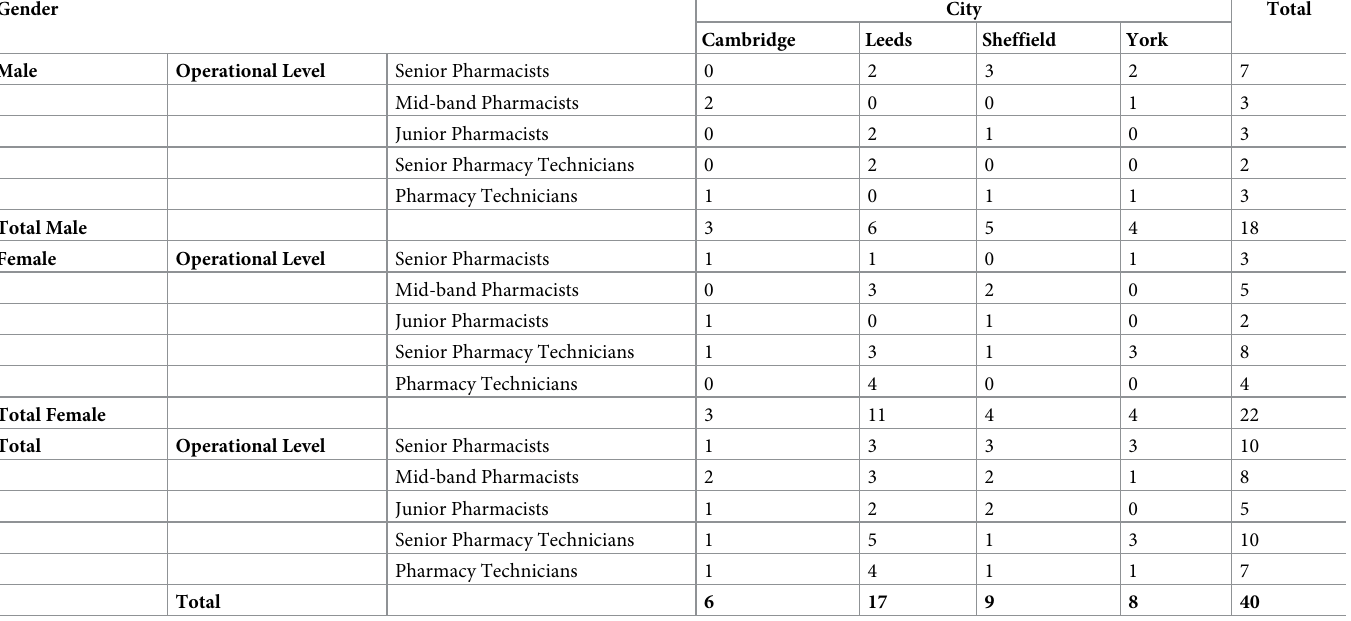
Table 2. Demographic information for UK